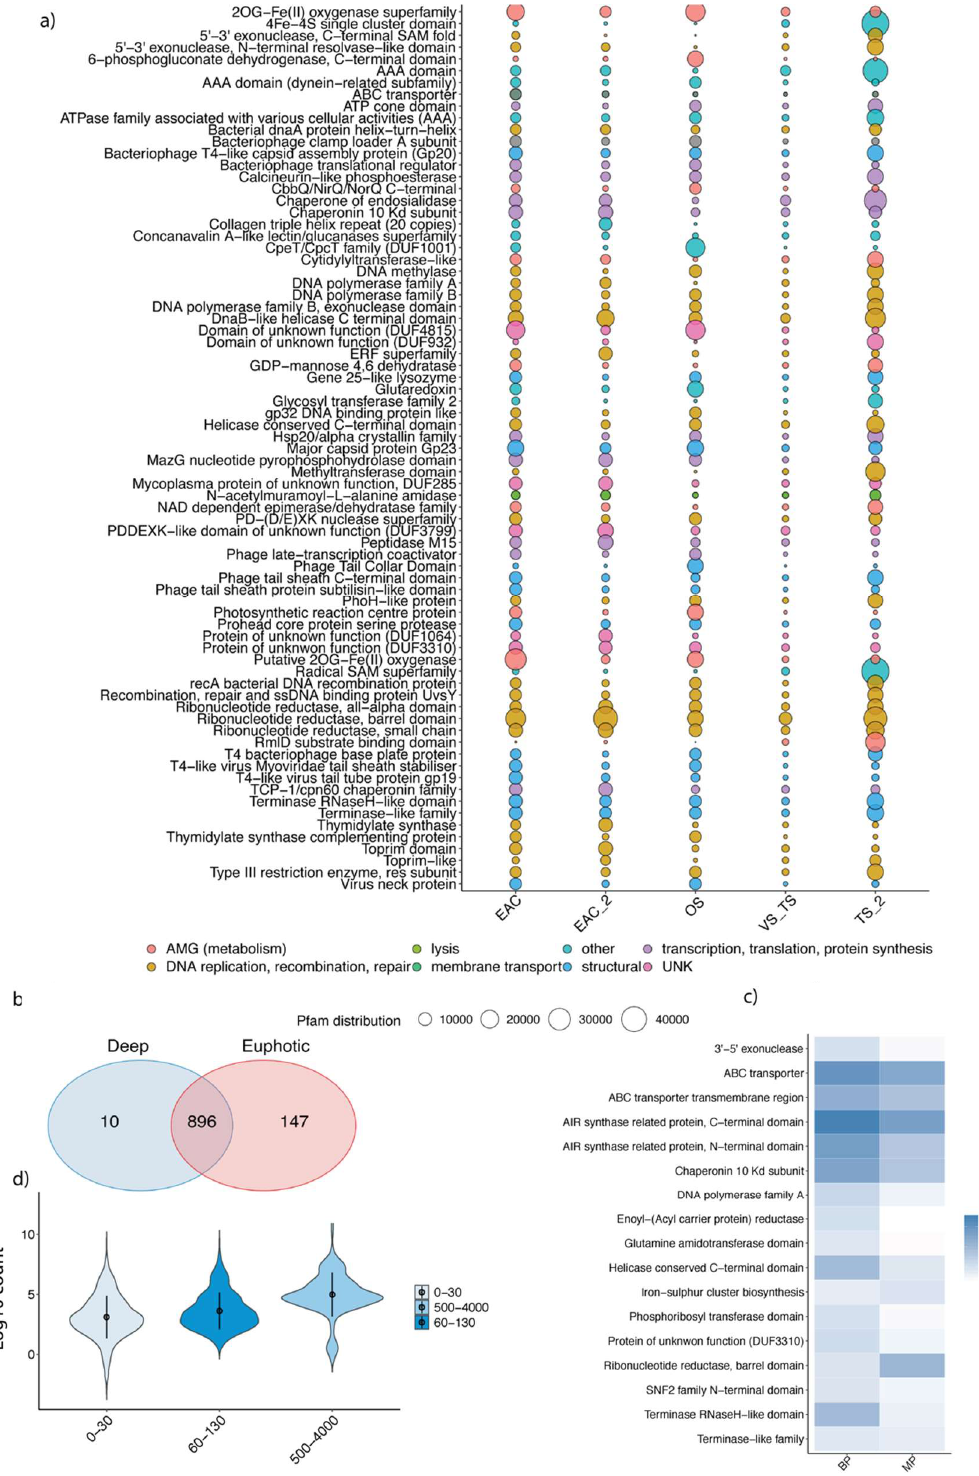
Figure 6. ( a ) Differential distribution of the 80 most abundant Pfam in the different clusters of the euphotic zone. Function was assigned with Interproscan (v.5). Pfam descriptions are colour coded based on corresponding functional categories [38]. Samples are grouped based on hierarchal clusters, calculated using the SIMPROF test (Clustsig). Size of the bubble is relative to Pfam abundance. ( b ) Venn diagram illustrating the differential distribution of shared and unique annotated viral genes between the aphotic and the euphotic zone. ( c ) Differential distribution of the 17 most abundant Pfam in the aphotic zone. ( d ) Log scaled depth distribution of integrase genes from the viral database.